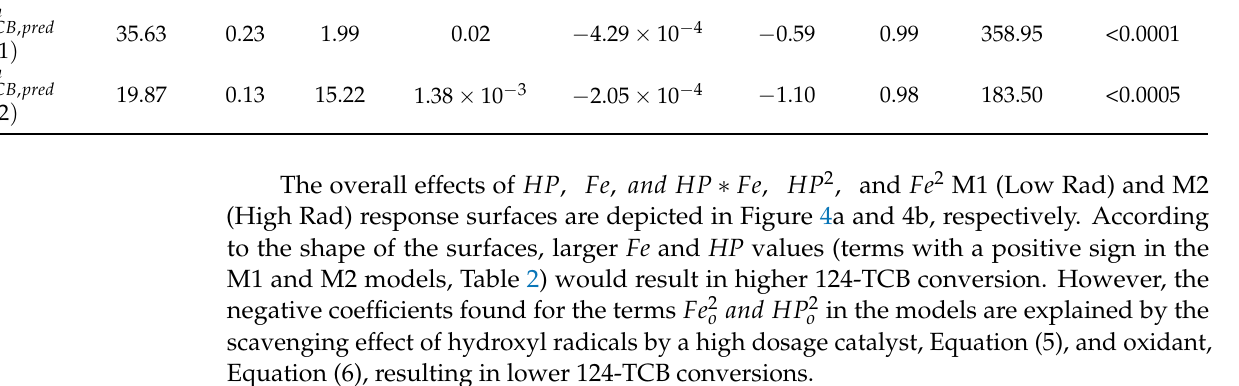
Table 2. Coefficients of the Response Surface Models M1 and M2 proposed. The coefficient of vari- ation (R 2 ), Fischer’s test value (F-value), and probability ( p -value) obtained from ANOVA tests are also shown.